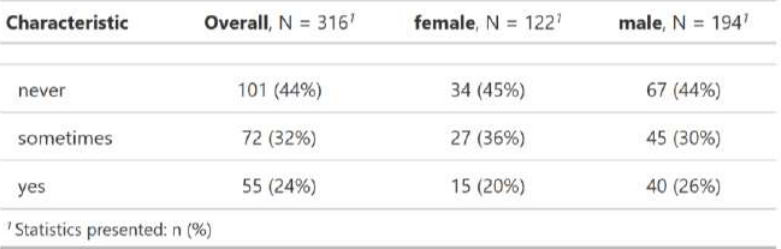
Table 8: How would you compare your experience about India with other countries? (Source: Authors‟ depiction